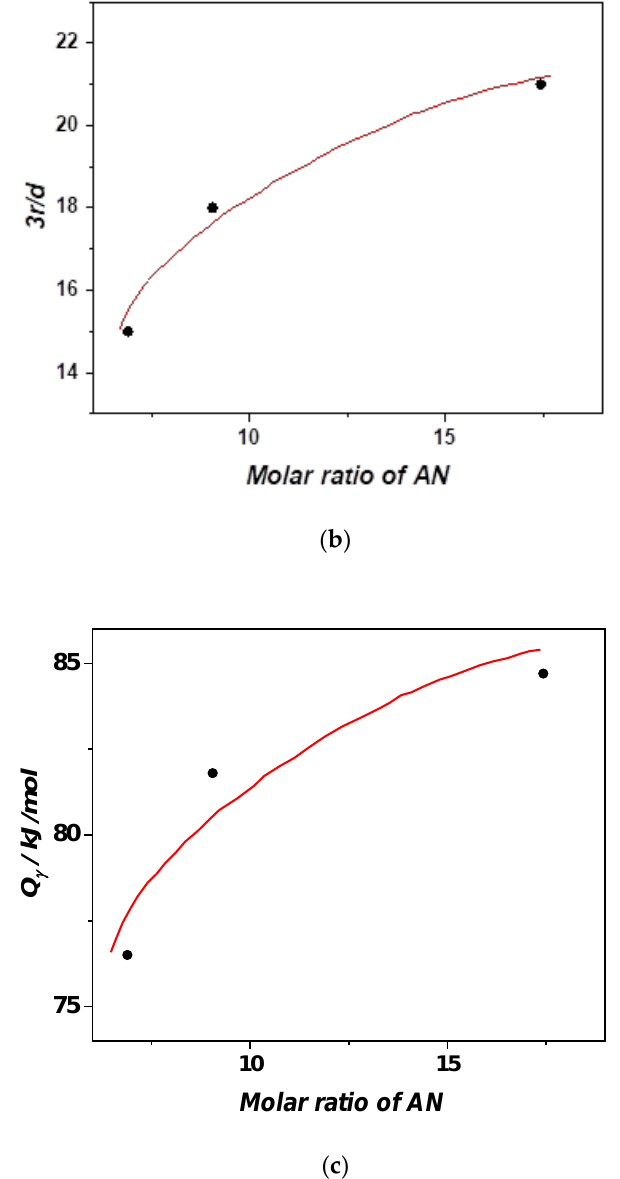
Figure 6. Variation of ( a ) ε s , ( b ) L values, and ( c ) Qγ values with the mole fraction of the AN monomer.